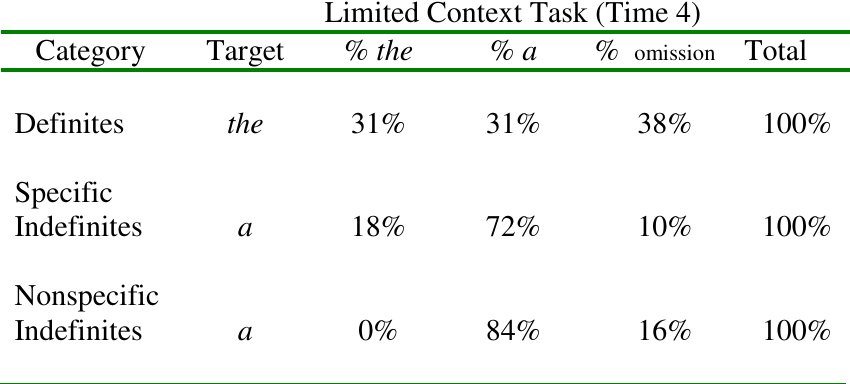
Article Use and Omission at Time